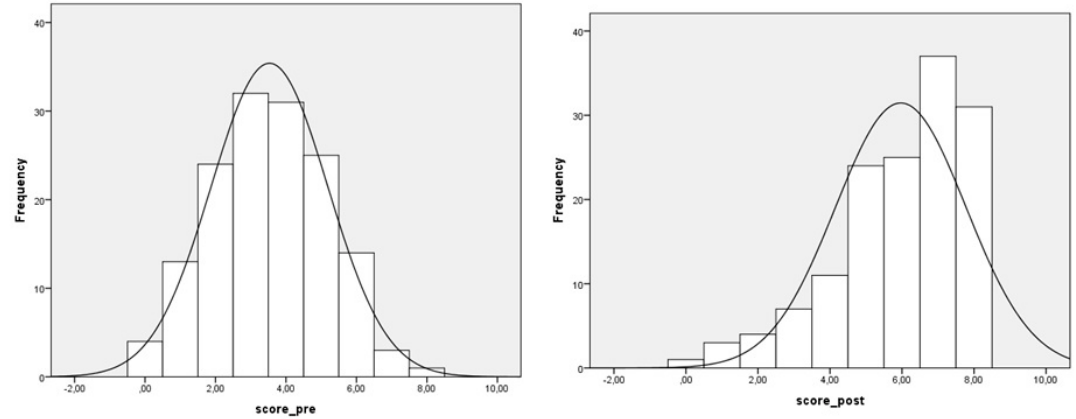
Figure 3. Pre-intervention and post-intervention knowledge score frequency distributions.